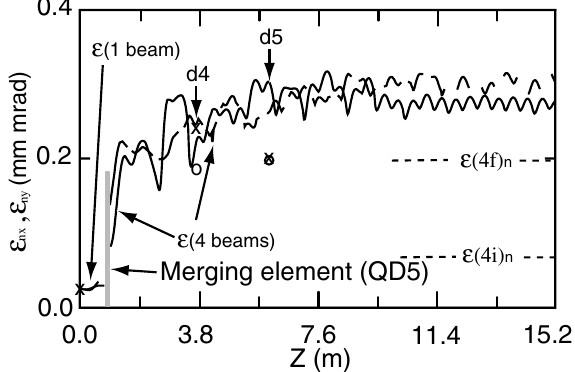
FIG. 11. Evolution of emittance from the PIC simulation , solid line for " ). The emittance is (dashed line for " nx ny calculated for all surviving particles in the simulation (95% at d 5 ). Upstream of the merging element ( QD 5 ), the emittance of one of the four (2.6 mA) identical beams is shown. Downstream of the merging element, the emittance of the (cid:3) 10 mA merged beam is shown. The locations of the d 4 and d 5 diagnostic stations are indicated. The d 5 station is at the end of the region of rapid emittance growth. The points below the , curve are for the experimental data at d 4 and d 5 ( cross (cid:5) " nx ). The values " (cid:10) 4 i (cid:11) and " (cid:10) 4 f (cid:11) are from the ana- circle (cid:5) " ny n n lytical model described in the text.